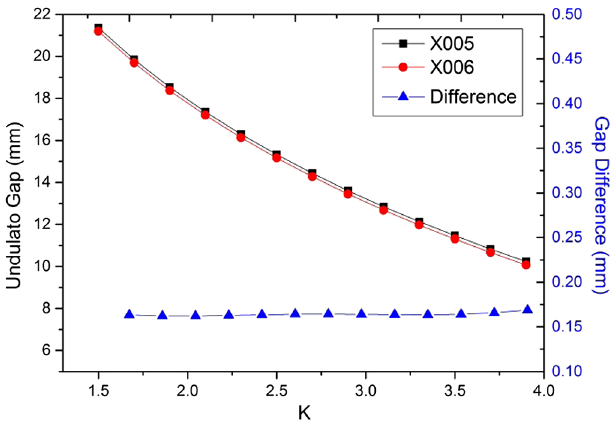
FIG. 6. Gap vs K-parameter for the U40-X005 (black squares) and U40-X006 (red circles). The difference is shown by the blue